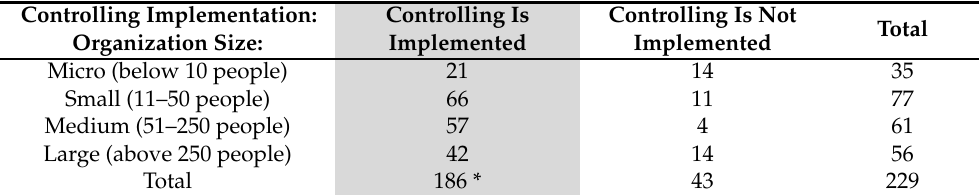
Table 1. Research sample characteristics concerning organization size and controlling implementa-